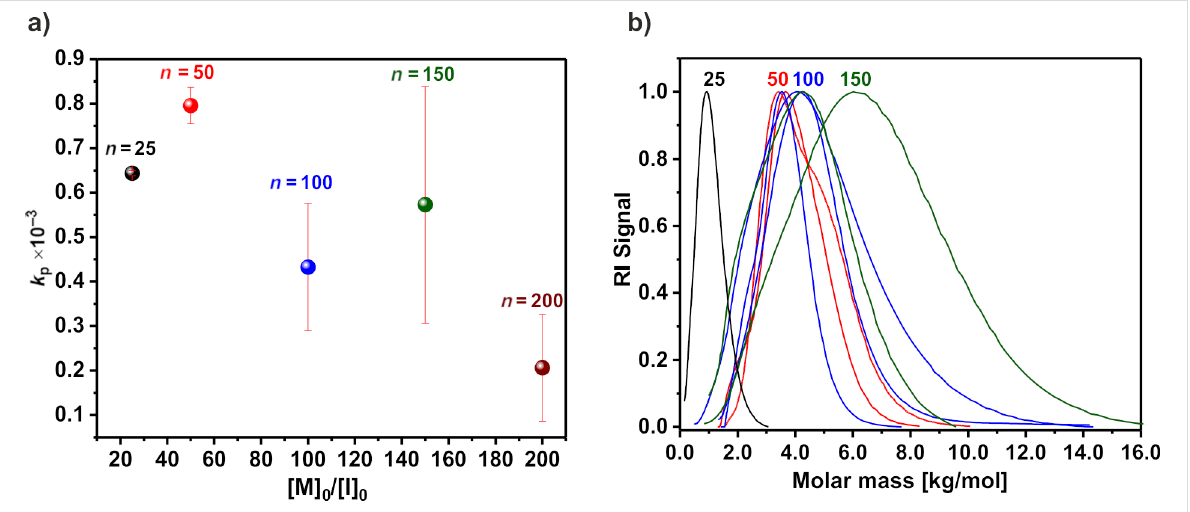
Figure 7: Investigation of 2-ethyl-2-oxazoline polymerization initiated with EtOxMeOTf at different monomer/initiator ratios. (a) Dependence of the apparent polymerization constant on the chain length, calculated from the first-order kinetic plot for the cationic ring-opening polymerization of 2-ethyl- 2-oxazoline initiated by EtOxMeOTf in DLG at 60 °C and (b) HFIP SEC traces of the resulting poly(2-ethyl-2-oxazoline)s.